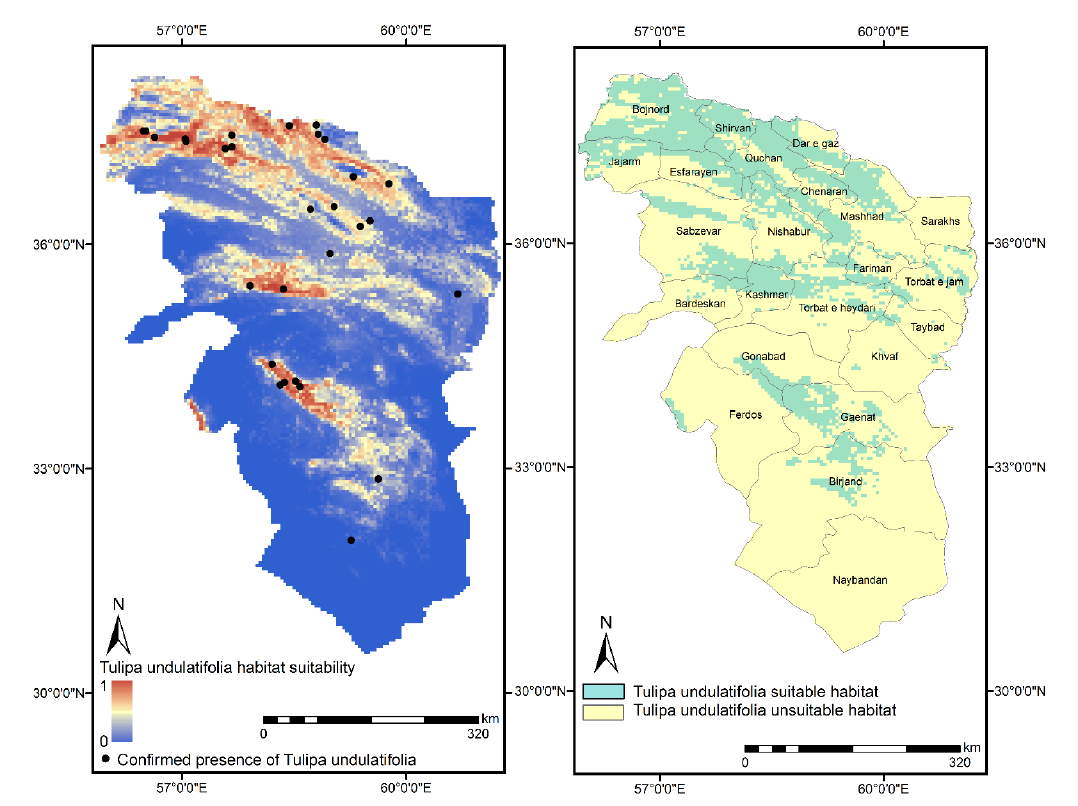
Fig. 7: Habitat suitability of Tulipa undulatifolia and its suitable habitats in the cities of Khorasan region.